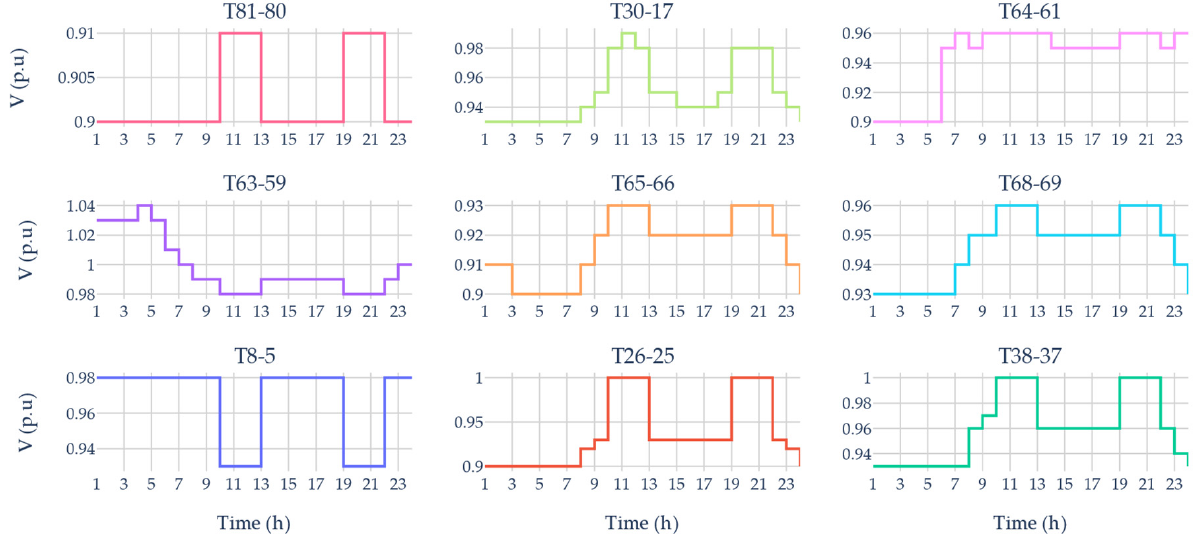
Figure 11. Tap position settings over one operation day (values expressed in p.u) for the IEEE 118-bus test system.